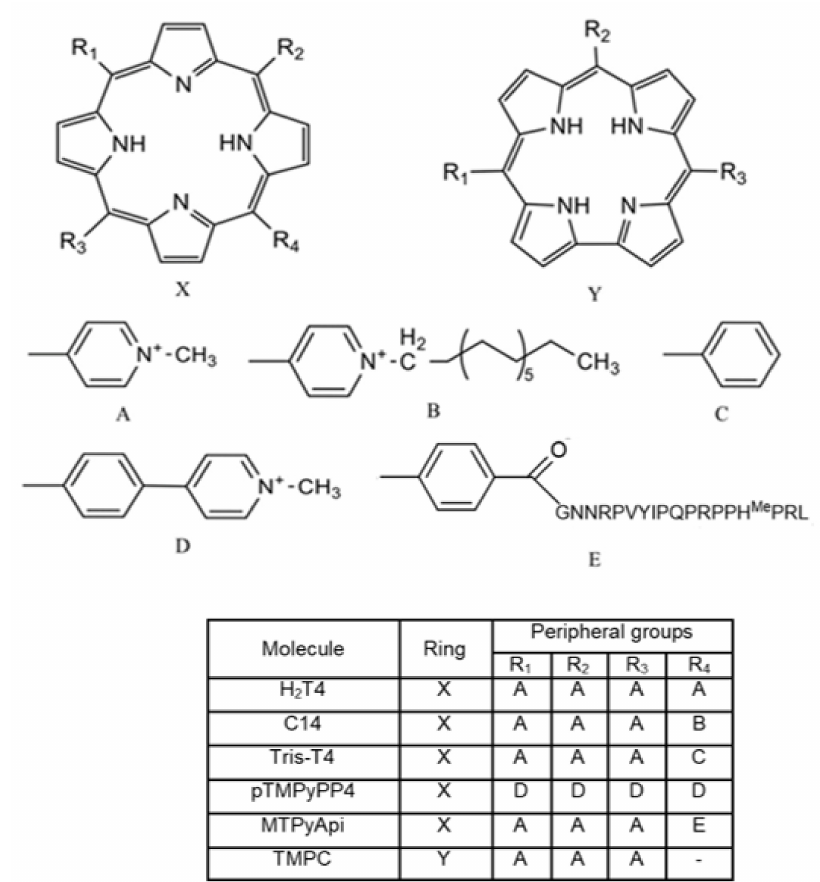
Figure 1. Porphyrin derivatives used in this